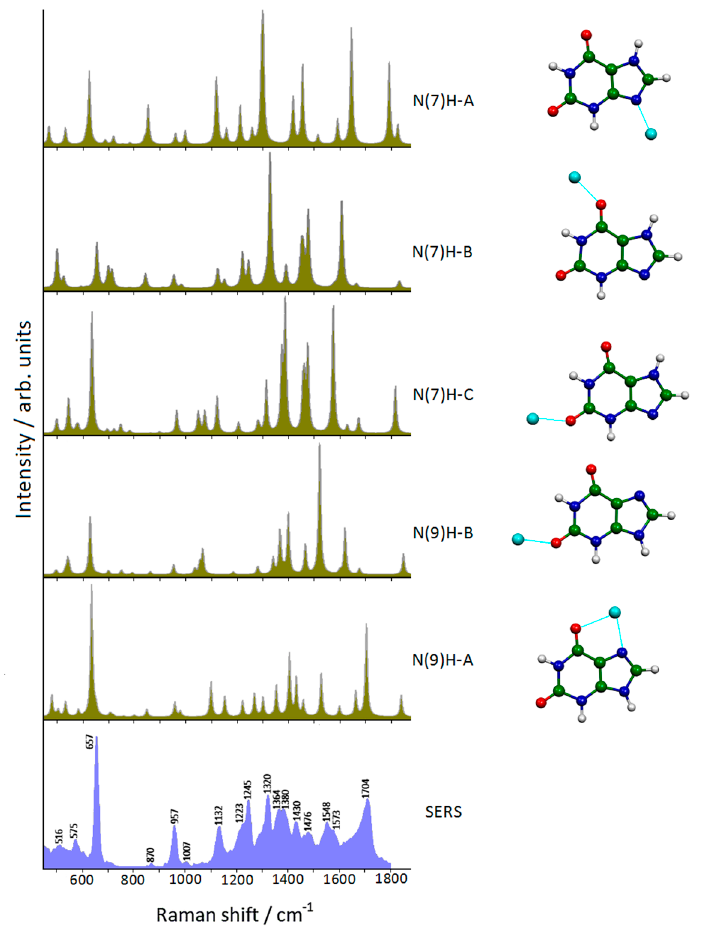
Figure 2. DFT-simulated Raman spectra of xanthine–silver complexes compared with the observed SERS spectrum of xanthine adsorbed on Ag colloidal nanoparticles (1064 nm laser